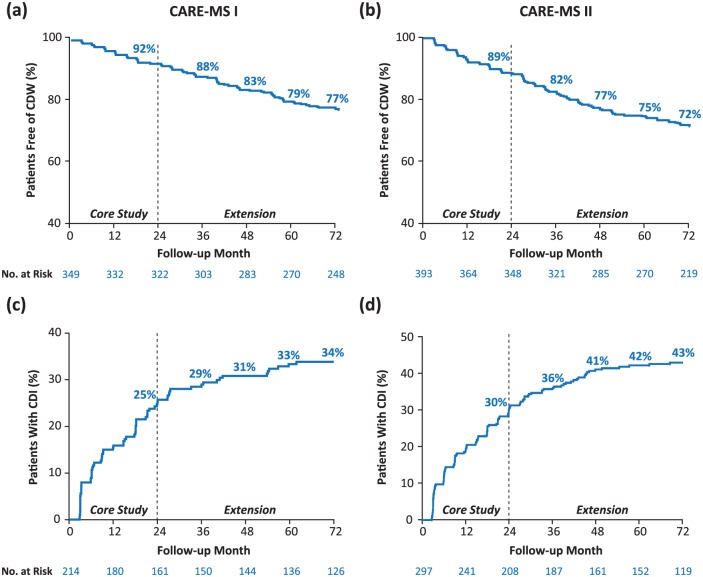
(a, b) The 6-month CDW and (c, d) 6-month CDI through 6 years in patients from CARE-MS I and II.4,5 Number at risk is the number of patients who remained on study and who had yet to experience CDW. For CDI analyses, number at risk is the number of patients with baseline EDSS of ⩾2.0, who remained on study, and who had yet to experience CDI.CARE-MS, Comparison of Alemtuzumab and Rebif® Efficacy in Multiple Sclerosis; CDI, confirmed disability improvement; CDW, confirmed disability worsening; EDSS, Expanded Disability Status Score